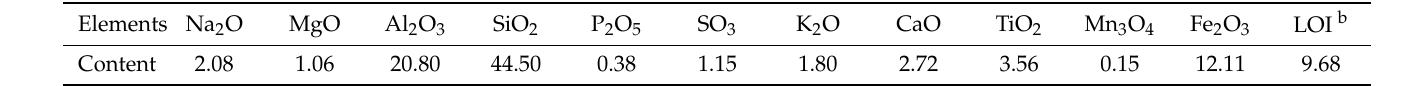
Table 3. The main chemical components’ content in the CFA sample from the Qianxi power plant in Guizhou (in wt%) a .